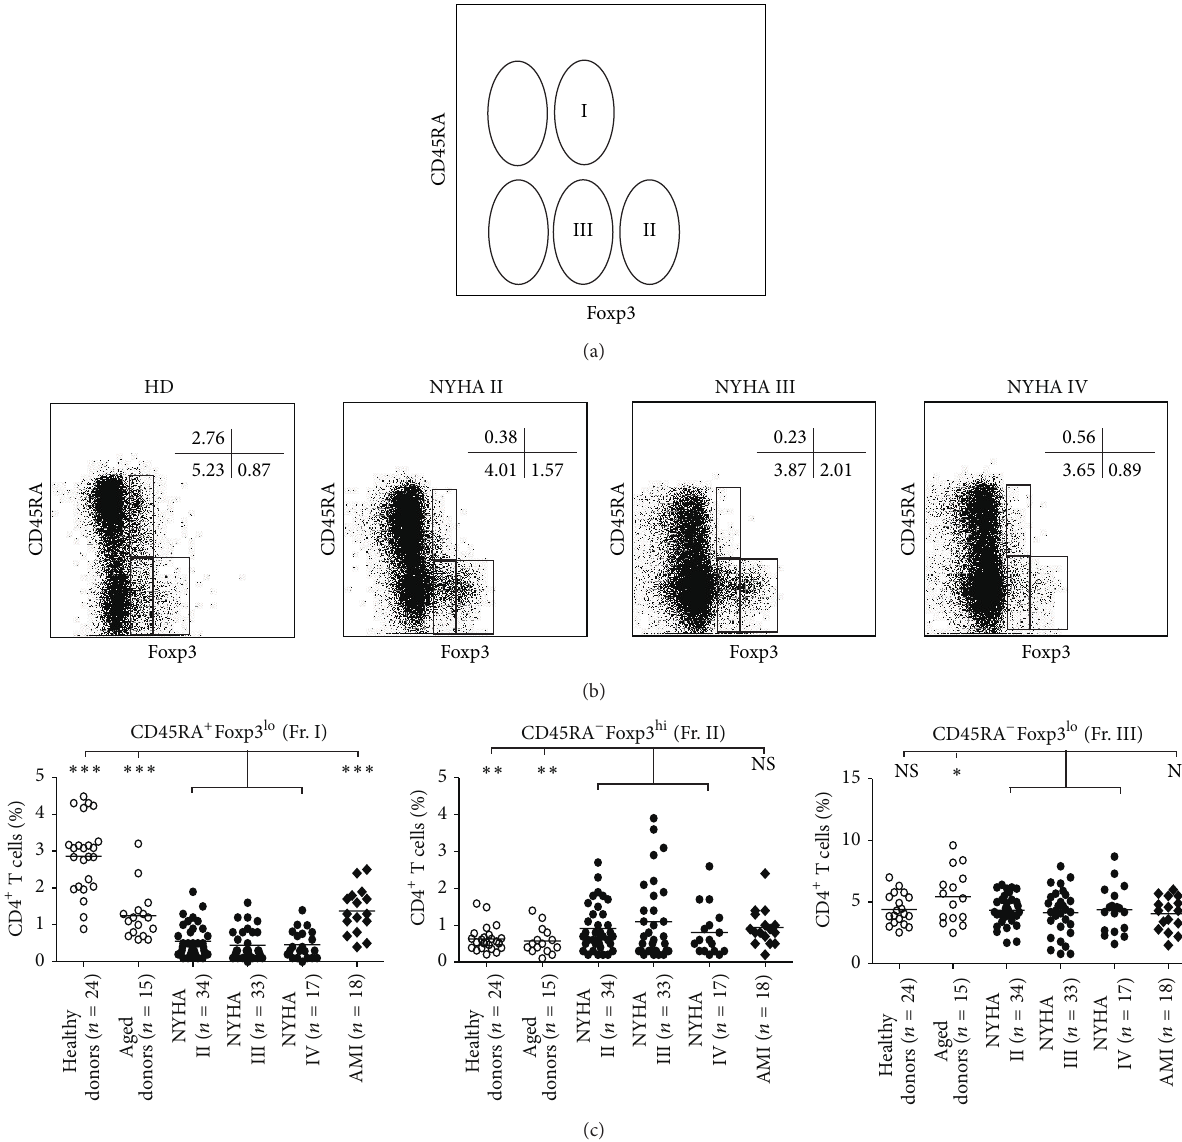
Figure 3: Variations of Foxp3 + cell subpopulations under physiological and CHF conditions. (a) Flow cytometry of PBL gated on CD4 + T cells isolated from PBL. A schematic of T cell subpopulations separated based on Foxp3 and CD45RA. (b) Flow cytometry of PBL gated on CD4 + T cells isolated from a healthy adult, an old donor, and three patients from each clinical stage. Percentage of each quadrant in each staining combination is shown. (c) Percentages of each Foxp3 + subset among CD4 + T cells in indicated numbers of patients with CHF NYHA II/III/IV, AMI, aged donors (between 79 and 90 years old), and healthy donors (between 18 and 60 years old). Black horizontal bars represent mean percentage. Data represent the mean ± SEM; * 𝑃 < 0.05 , ** 𝑃 < 0.01 , and *** 𝑃 < 0.001 .